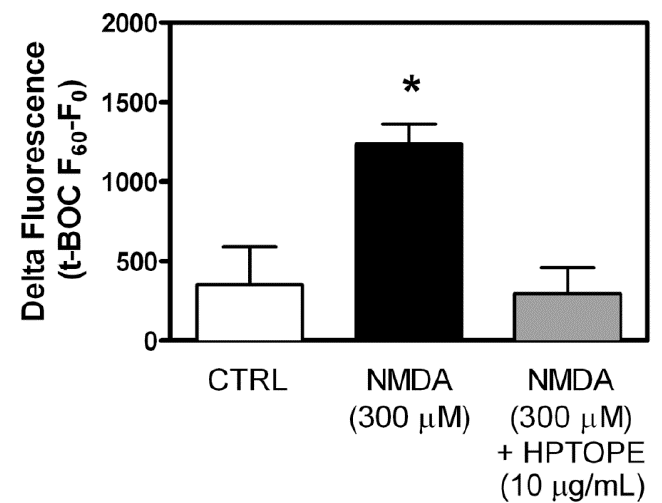
Figure 5. Evaluation of calpain-1 activity in cortical neurons following NMDA receptor (NMDAR) stimulation in the presence of HPTOPE. t -butyloxycarbonyl ( t -BOC)-loaded neurons were treated with the indicated stimuli. The protease activity is expressed as “delta fluorescence”, which is calculated as the di ff erence between the t -BOC-dependent fluorescence measured at 60 min (F 60 ) and the one recorded at the starting time (F 0 ). Data are means ± SEM from five independent experiments in triplicate. * p < 0.05 vs. control and ** p < 0.01 vs. NMDA, according to ANOVA, followed by Tukey’s post-hoc